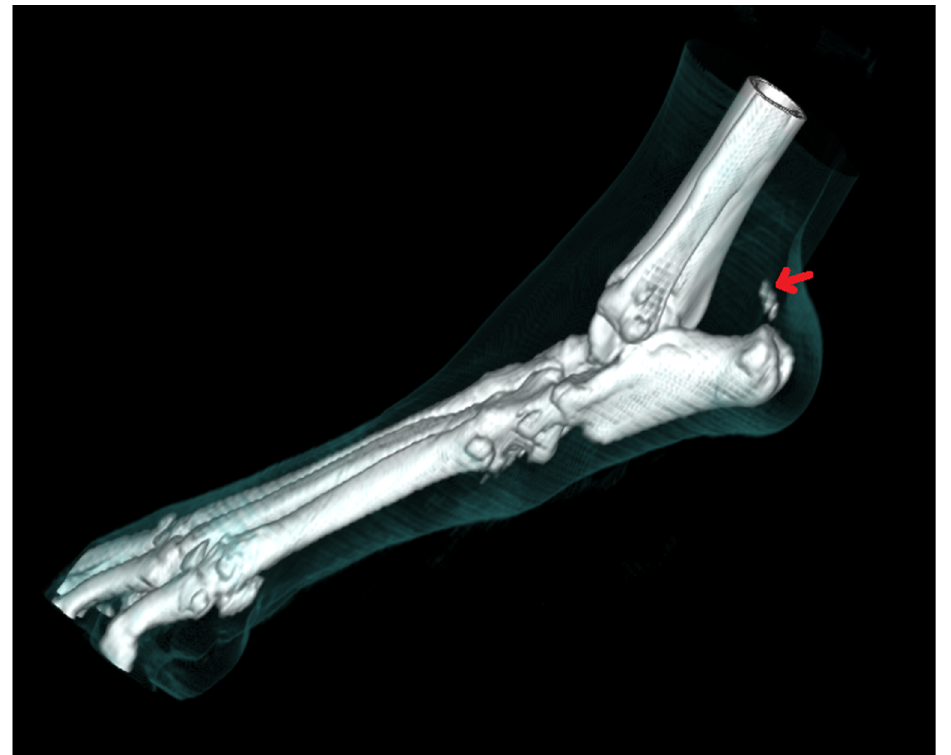
Figure 3. CT 3D image reconstruction of the mineralization of the Achilles tendon (arrow).